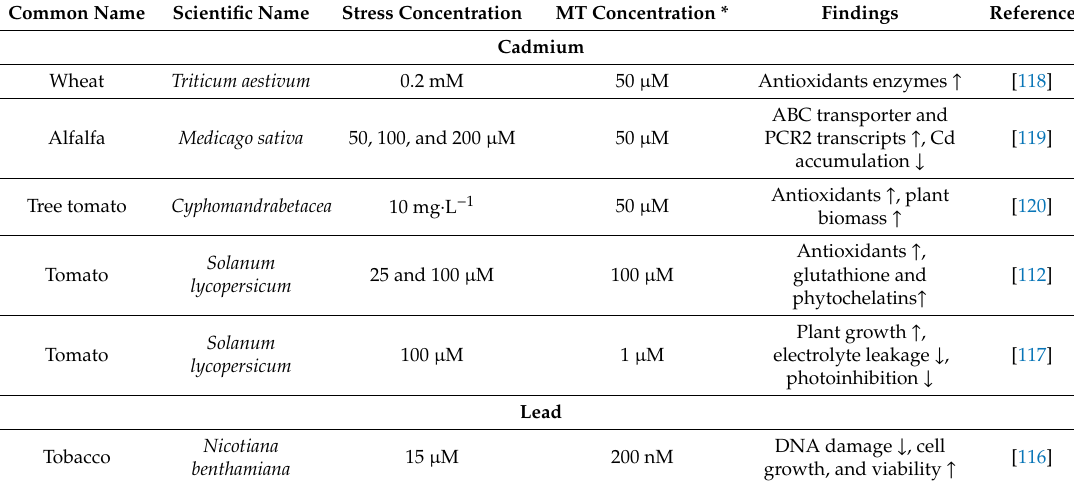
Table 3. Role of melatonin in heavy metal stress